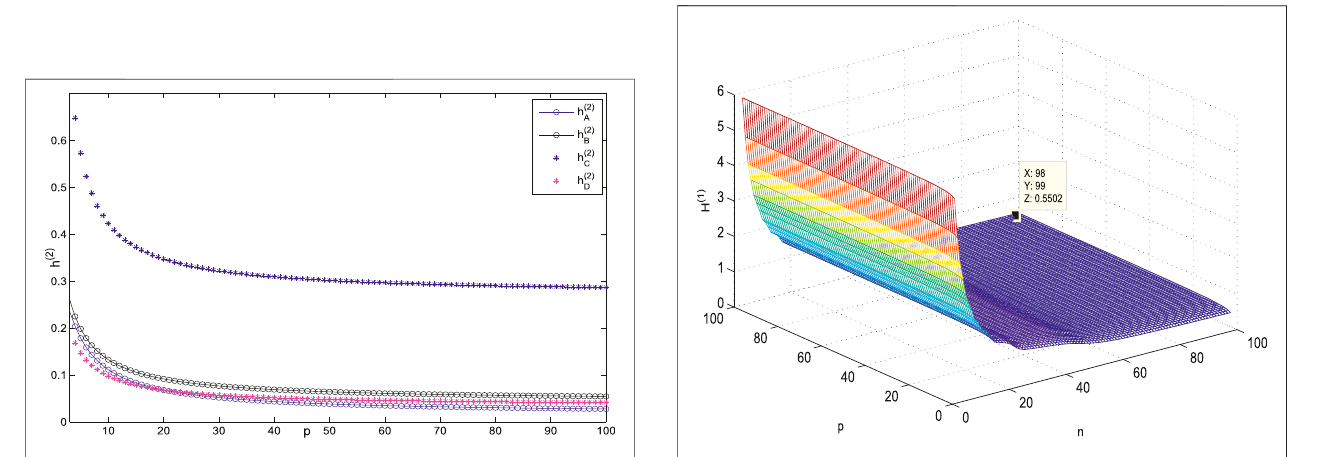
FIGURE 8 | The change of H (1) for B .